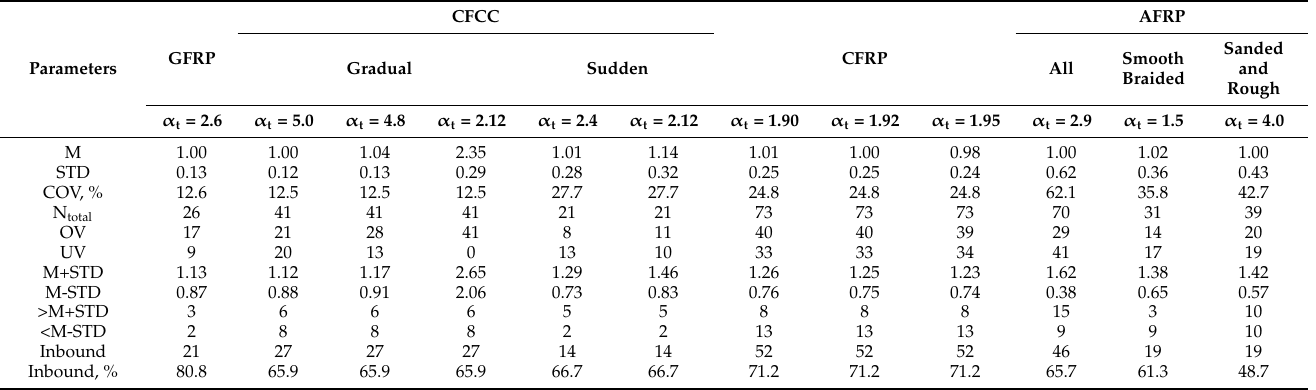
Table 12. Summary of the statistical results for L t.teor /L t.exp